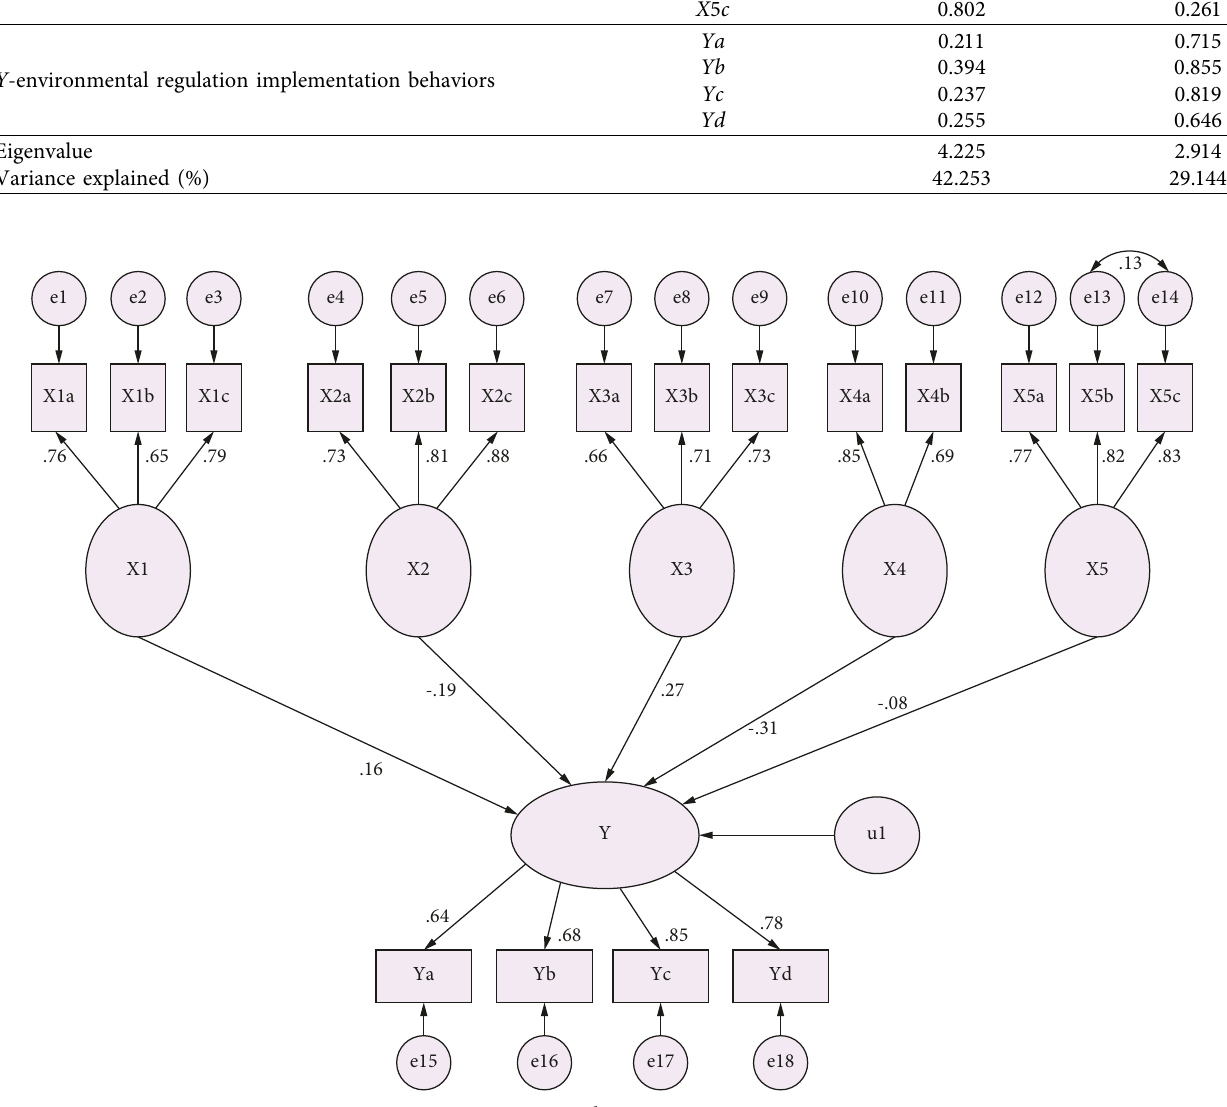
Table 8: Estimation results of path coefficient in